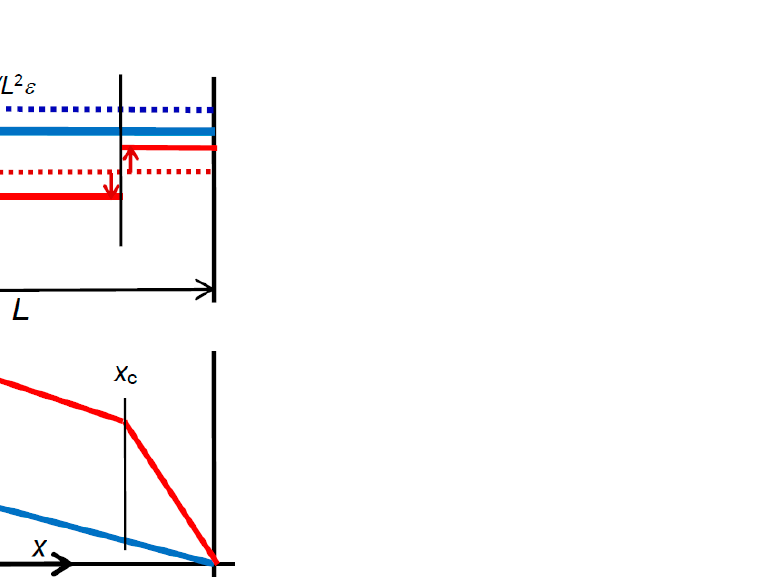
Figure 6. ( A ) Illustration of the model of ionic distributions caused by the applied voltage V 0 and the charge ± e , ( B ) the equivalent circuit for the four capacitances, and ( C ) predicted one-dimen- sional distribution of ions.